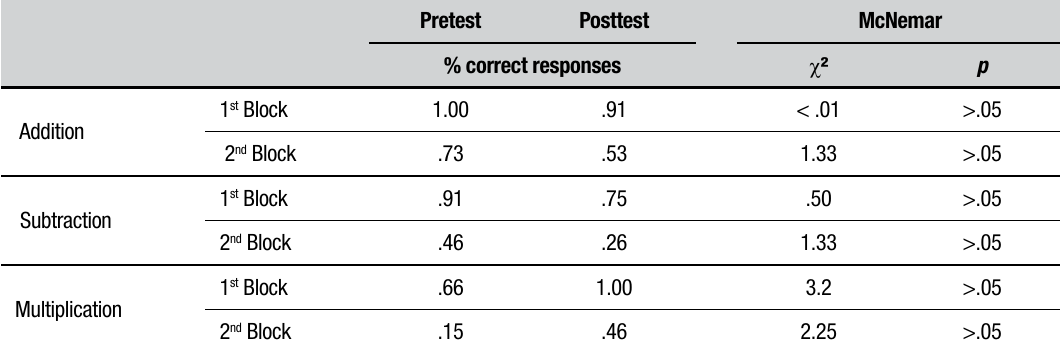
table 1. HV’s accuracy on the pretest and post-test for the